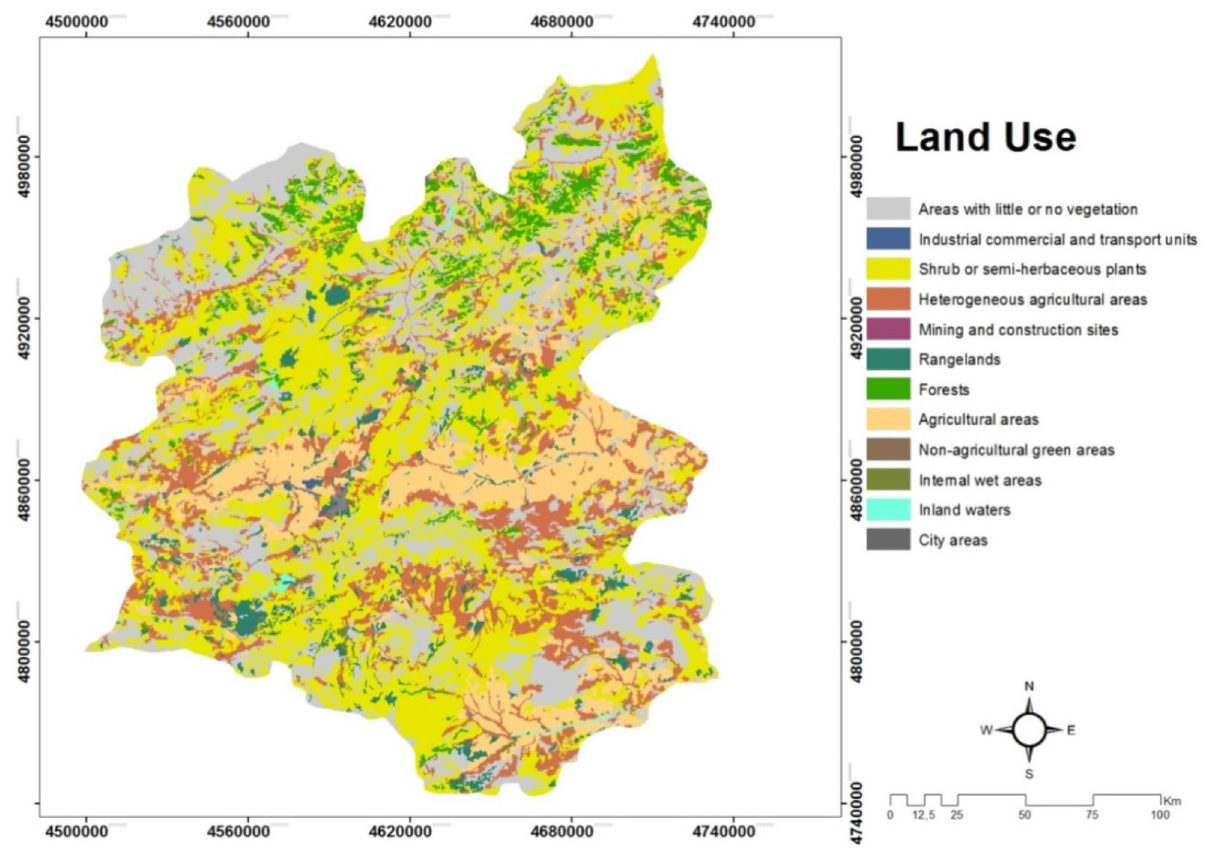
Figure 6. The map of land use Erzurum